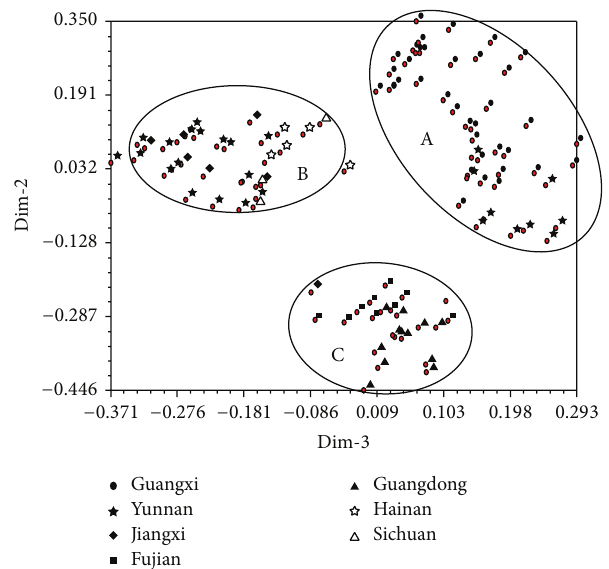
Figure 3: Principal components analysis using ISSR data for the 100 S. scitamineum isolates (numbers 1–100).